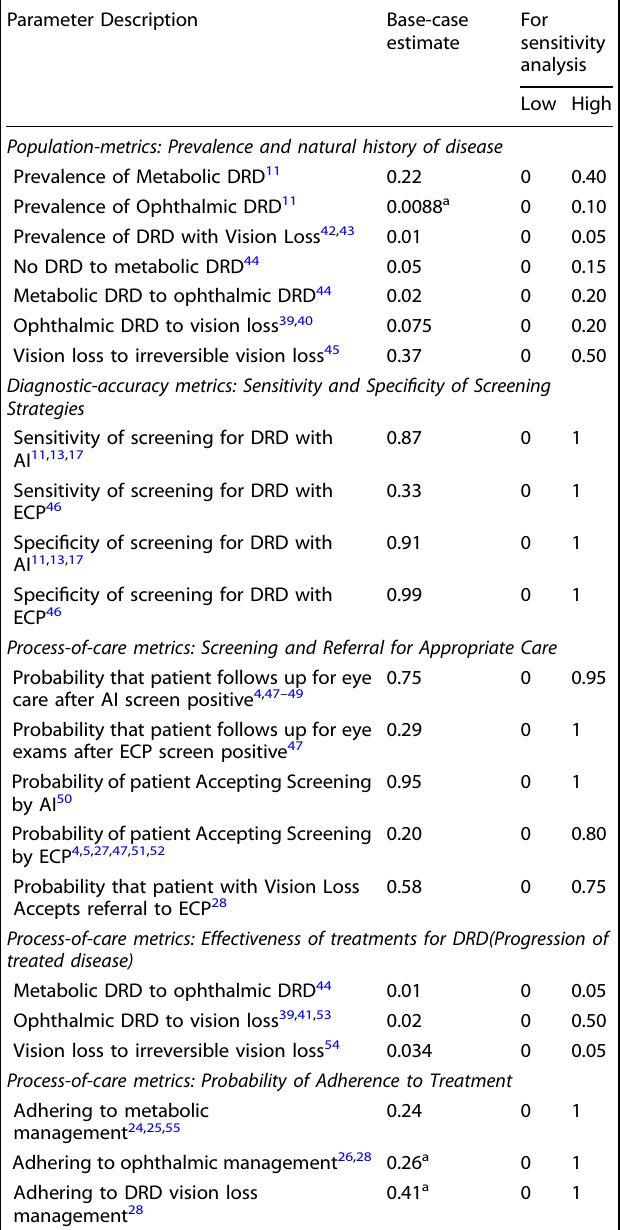
Table 1. Parameters for the decision